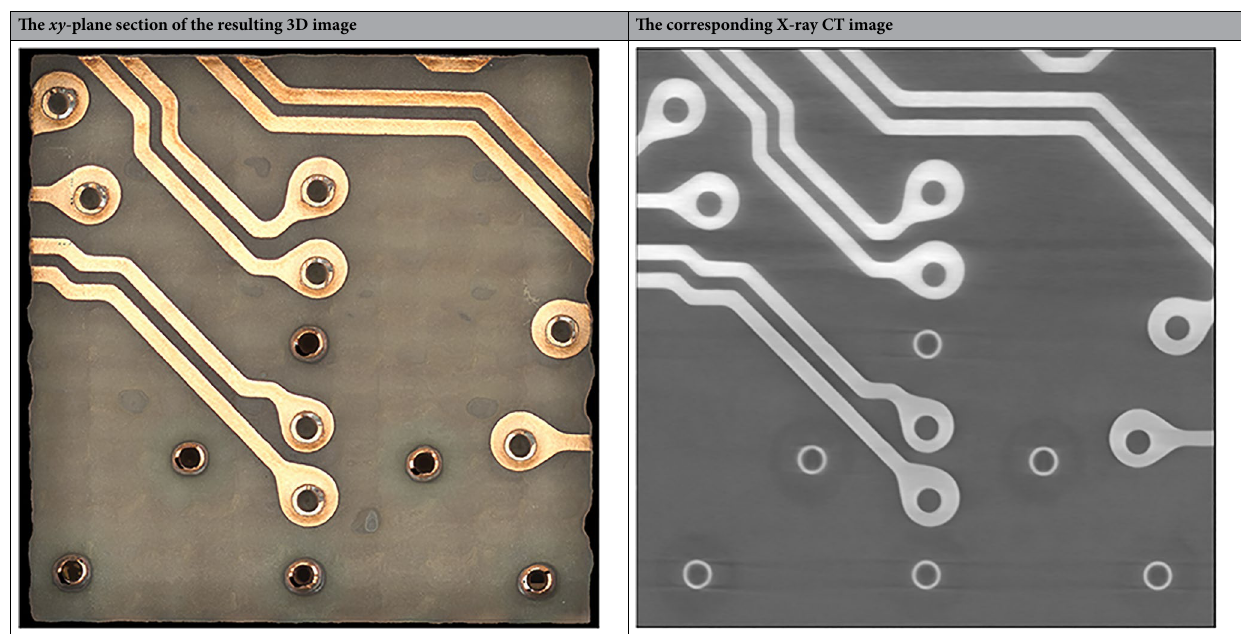
Table 4. Some xy -plane sections of the resulting PCB 3D image using the proposed method and the corresponding X-ray CT images.